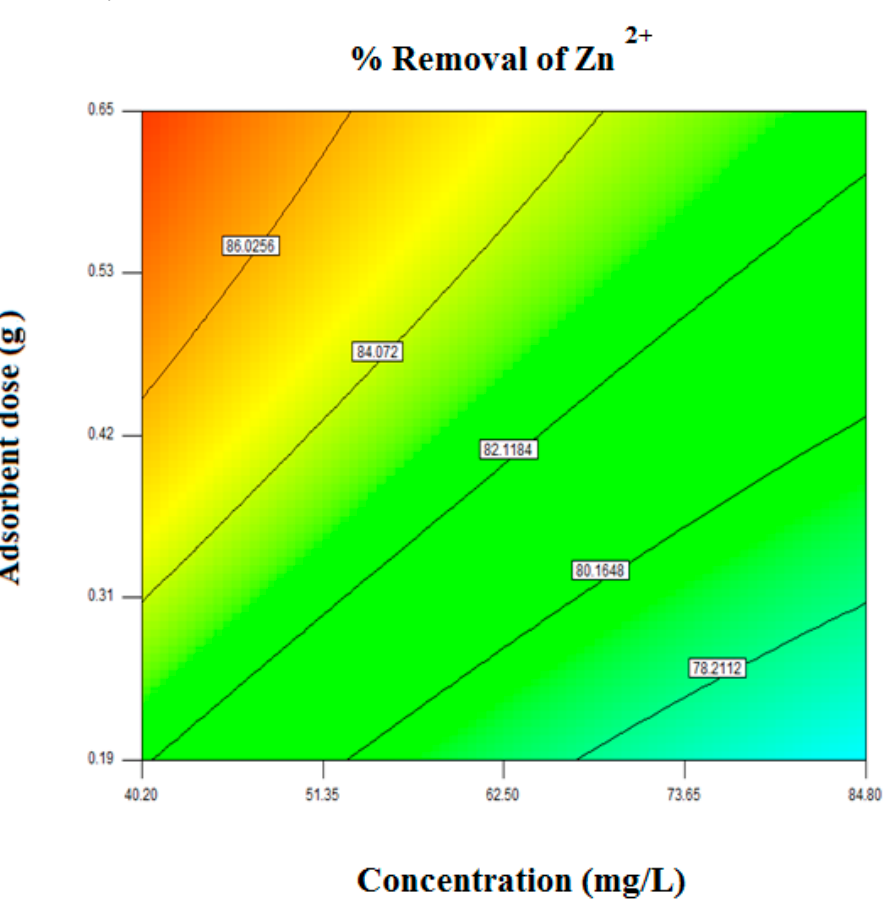
Figure 9. Contour plot of adsorbent and concentration for the highest removal efficiency of Zn 2+ . The optimum operating condition was found at the initial concentration of metal ion 43.18 mg/L, adsorbent dose 0.62 g and system temperature 313.15 K. The experimental and predicted removal efficiency at the optimum condition was found as 86.05% and 85.02%, respectively. The error obtained between model predicted and the actual value is less than 1.18% which indicates that the model is accurate for Zn 2+ removal. The optimum conditions in detailed are produced in Table 6. Table 6. Optimum conditions for the removal of aqueous phase Zn 2+ on the composite adsorbent. Condition